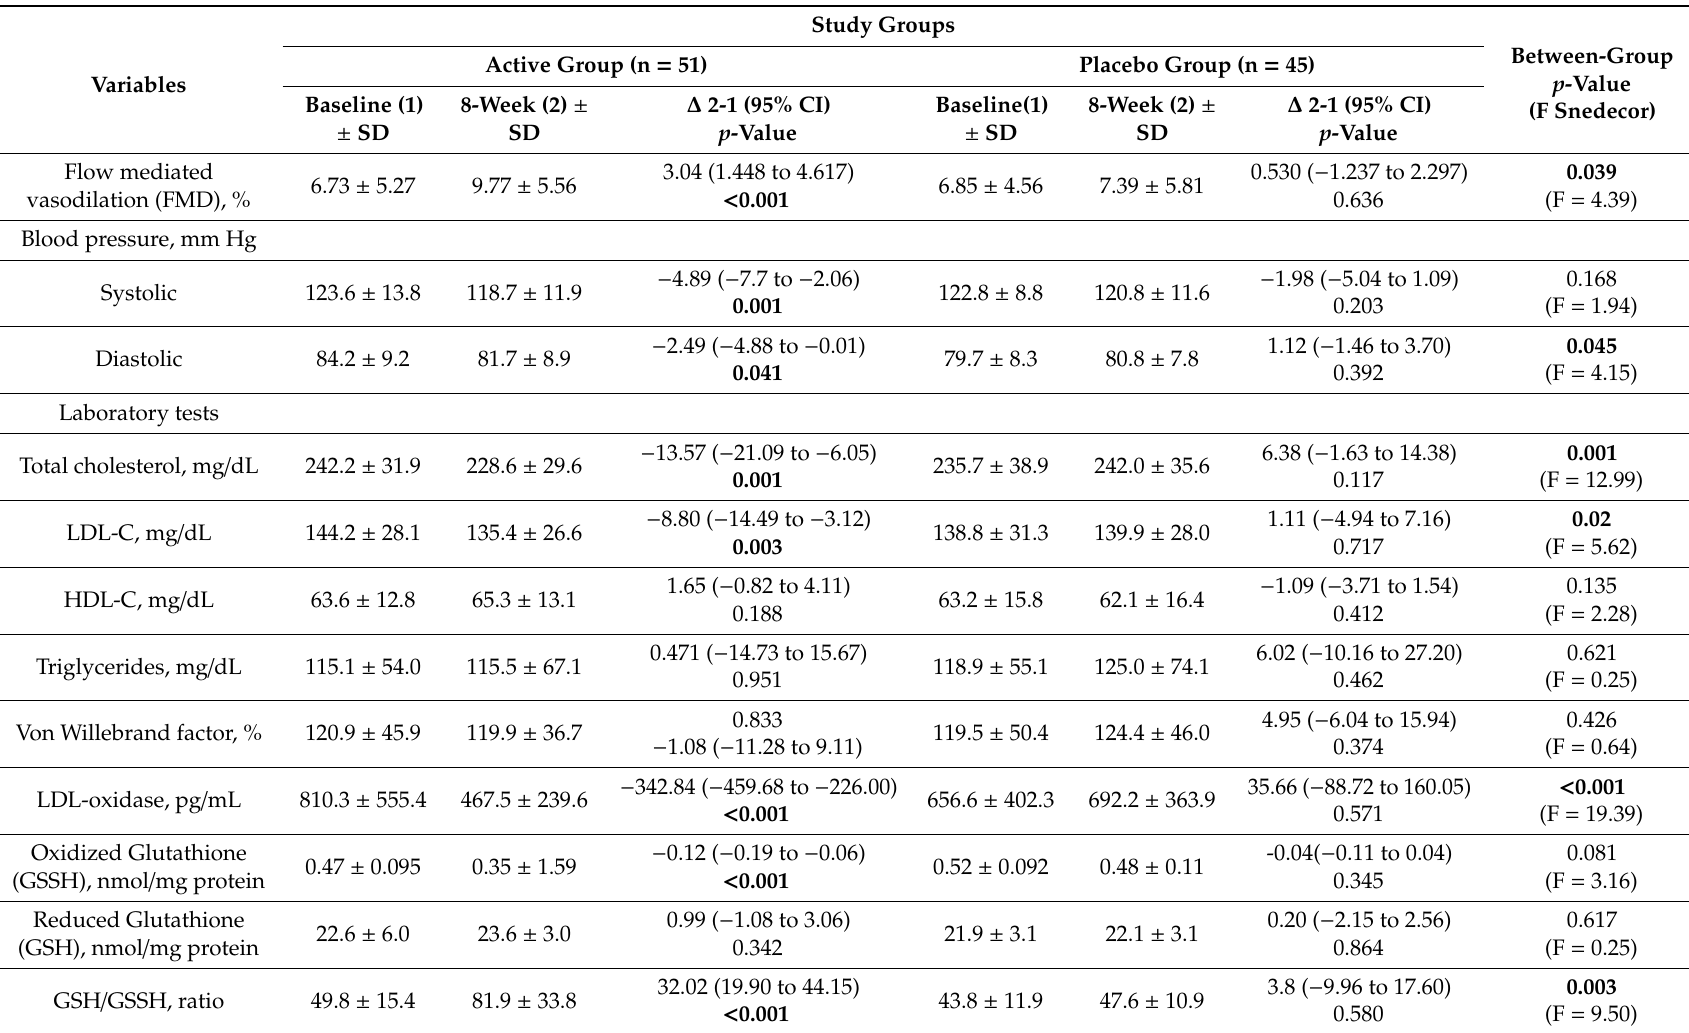
Table 1. Results of the study variables before and after consumption of the nutritional